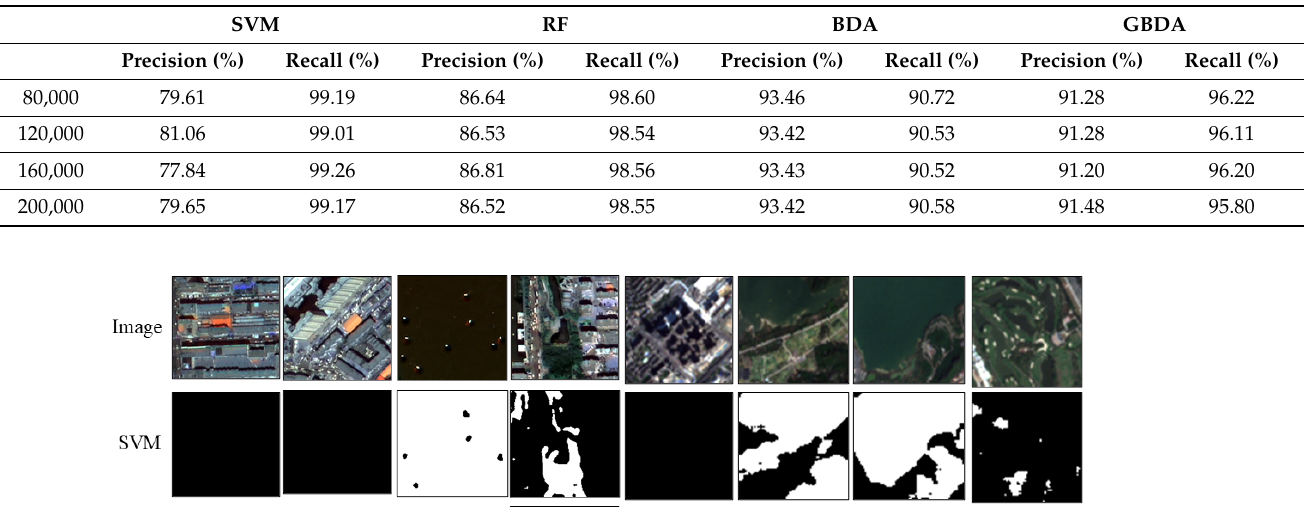
Table 4. Precision and recall of impervious surfaces of Sentinel-2 remote sensing images.